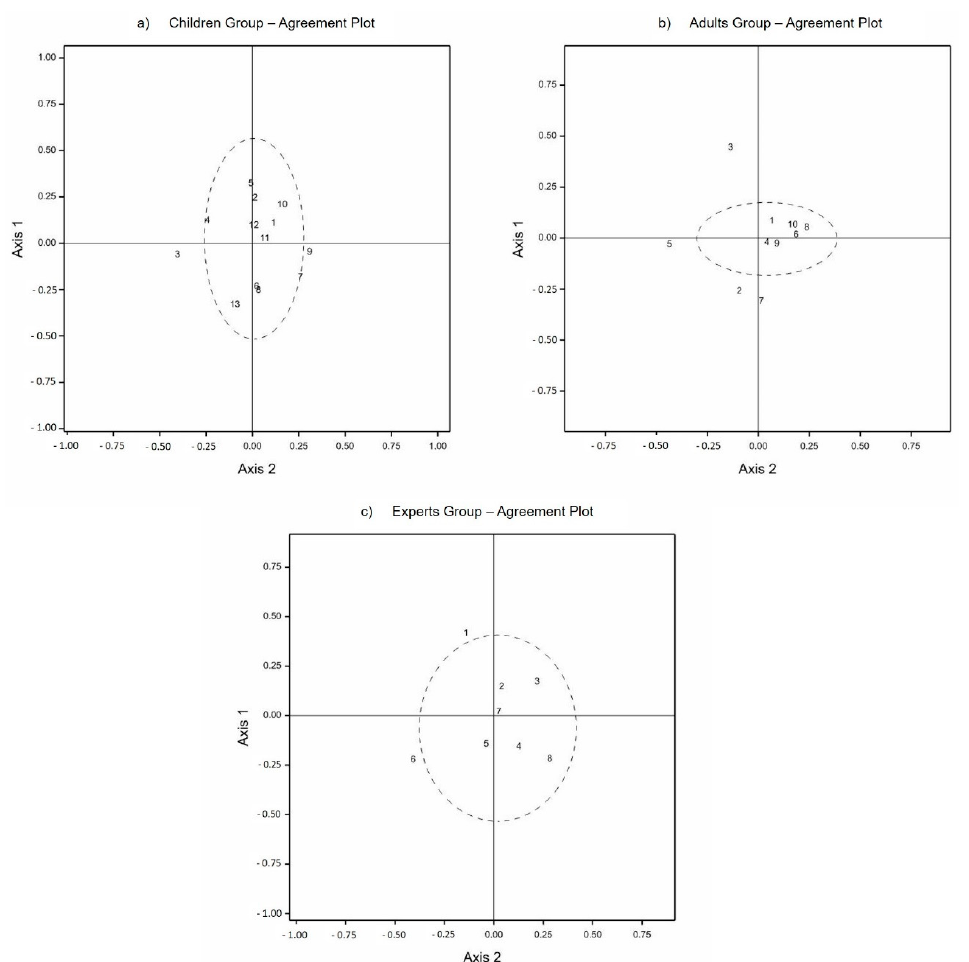
Figure 1. Observer plots of ( a ) children, ( b ) adults, and ( c ) experts.